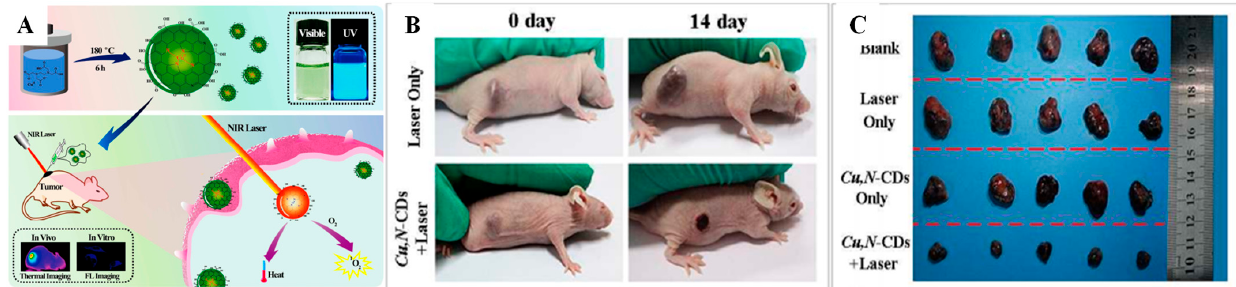
Figure 6. ( A ) Graphical representation of Cu,N-CDs with multimodal theranostics of combined PTT/PDT of mouse melanoma (B16) cells. ( B ) Photographic images of tumor-bearing mice with laser treatment on different days. ( C ) Corresponding photographs of tumors in the blank group (Blank without treatment), control groups (only Cu,N-CDs without laser and Laser only applied without Cu,N-CDs), and test group (Cu,N-CDs + Laser). In test group, significant reduction in the tumor size observed, while both control test group (Cu,N-CDs and Laser only) no effect is observed in the tumor size in comparison with blank group. Reproduced with permission [154]. Copyright 2018, Elsevier.